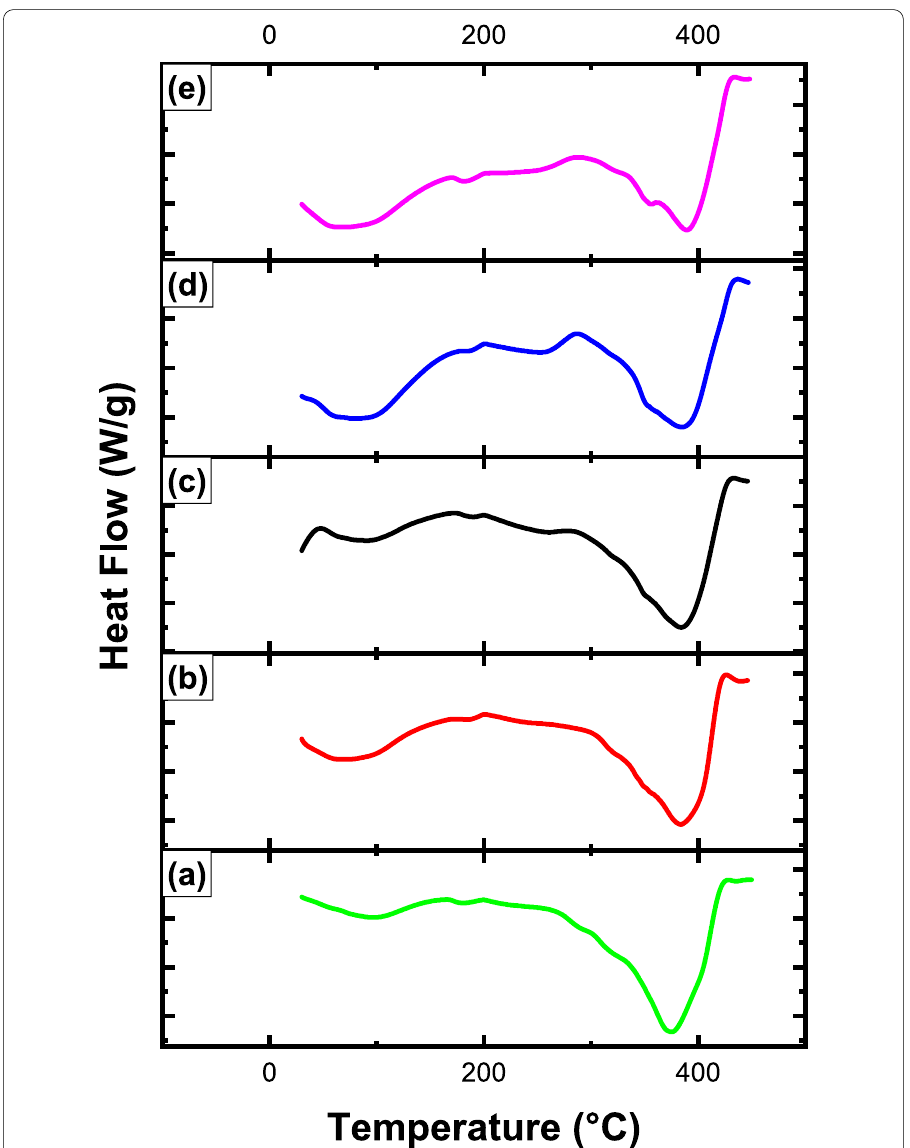
Fig. 3 DSC thermogram for a TF-NC0, b TF-NC5, c TF-NC10, d TF-NC15, e